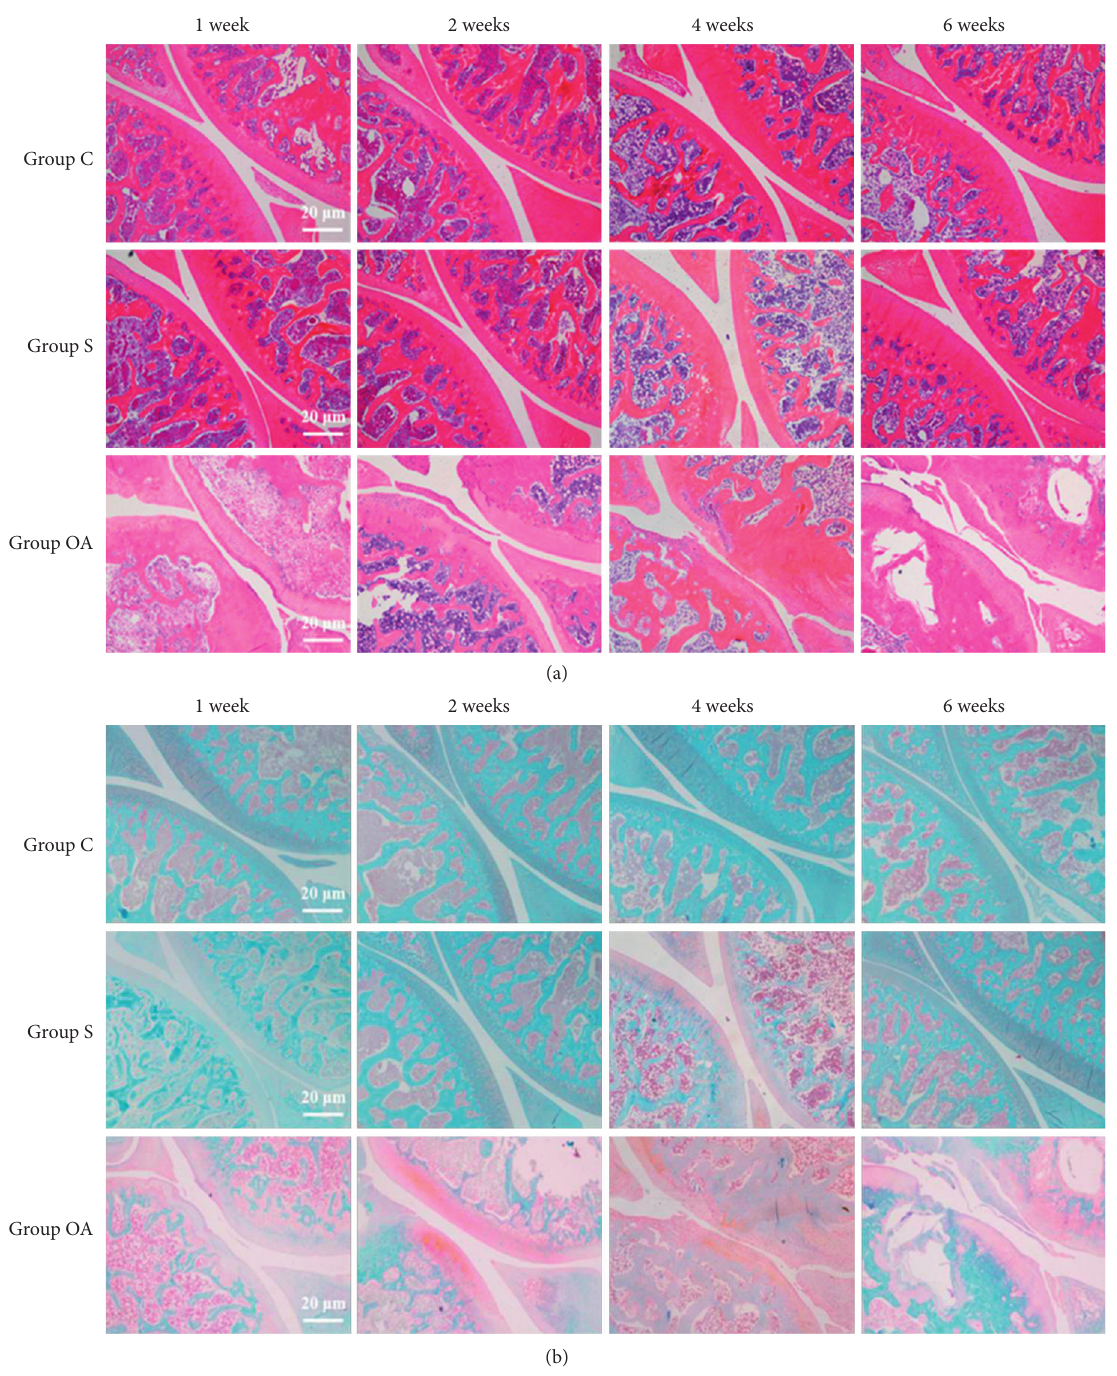
Figure 2: Pathological changes in the knee joints. (a) Hematoxylin-Eosin (HE) staining. (b) Safranin O-Fast Green staining. In group C, the articular cartilage surface was smooth and there was no crack formation, the cells were normal and arranged regularly, the tidal line was clear, and there was no bone hyperplasia. In the group OA, with the development of the OA, the destruction of cartilage surface is aggravated and even bone exposure occurred, the increasing exacerbation of cartilage matrix reduction and bone hyperplasia was apparent, the tidal line gradually blurred, and pathological changes showed typical advanced OA manifestations at four to six